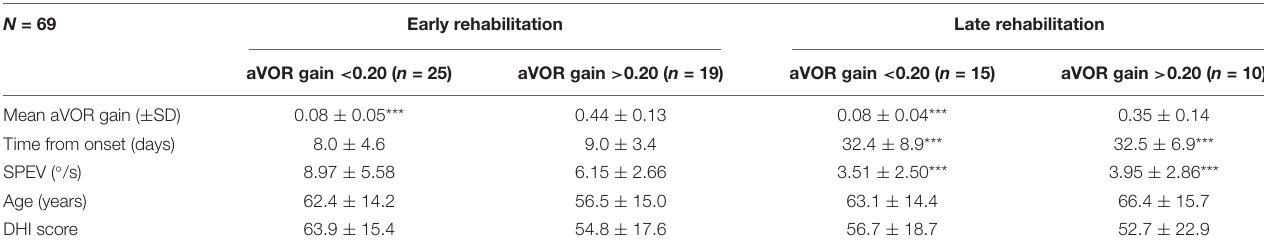
TABLE 1 | Main characteristics of the four sub-groups of patients with